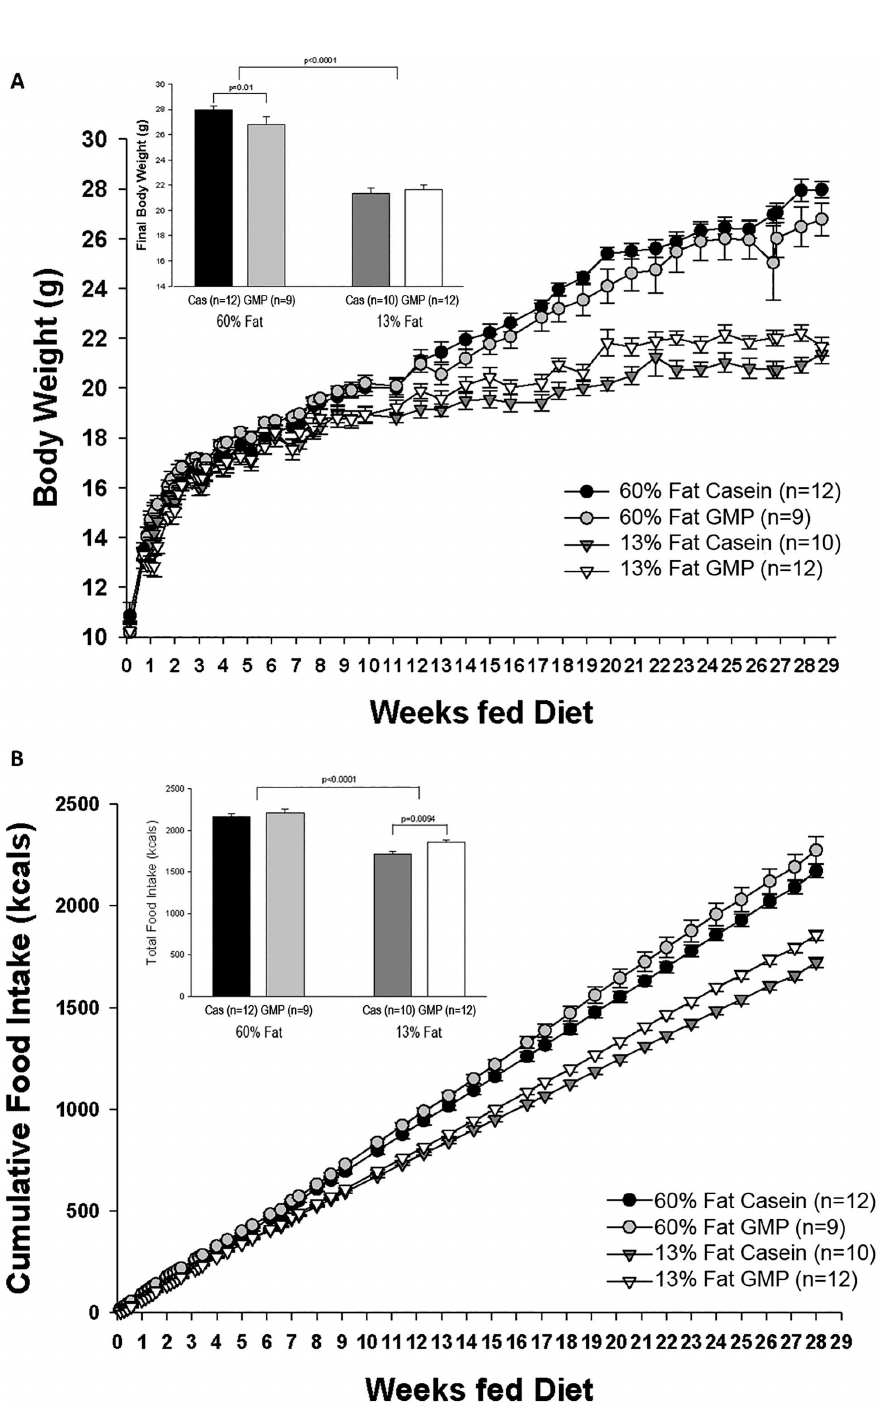
Fig 1. Body weight and food intake. Change in body weight (A) and cumulative food intake over time (B) of female mice fed 60%-fat casein, 60%-fat GMP, 13%-fat casein, and 13%-fat GMP diets from weaning (3week) through 32 weeks of age. Repeatedmeasures analysis showed a significant protein x fat x time interaction for body weight (A). The inset histogram displays final body weight of the female mice. Mice fed the high-fat diets weighedsignificantlymore at the end of the study (p < 0.0001) compared to mice fed the control diets. Mice fed the high-fat GMP diet weighedsignificantly less at the end of the study compared to mice fed the high-fat casein diet (p = 0.01). Repeatedmeasures analysis indicateda significant protein x fat x time interactionfor cumulative food intake (B). The inset histogram shows total caloric intake throughout the study. Mice fed the high-fat diets consumed significantly more kcals throughout the study than mice fed the